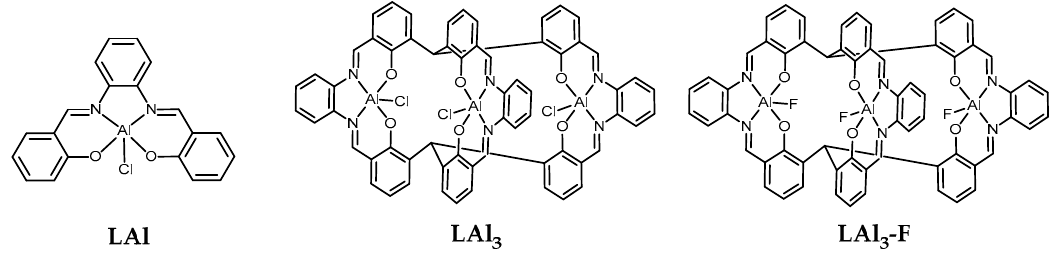
Figure 1. Chemical structures of the Al salophen complexes.